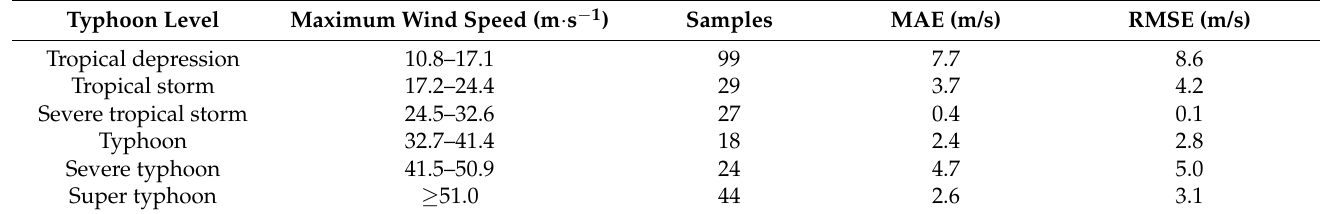
Table 8. Analysis of the typhoon intensity estimation of satellite cloud images acquired in 2019. Typhoon Level